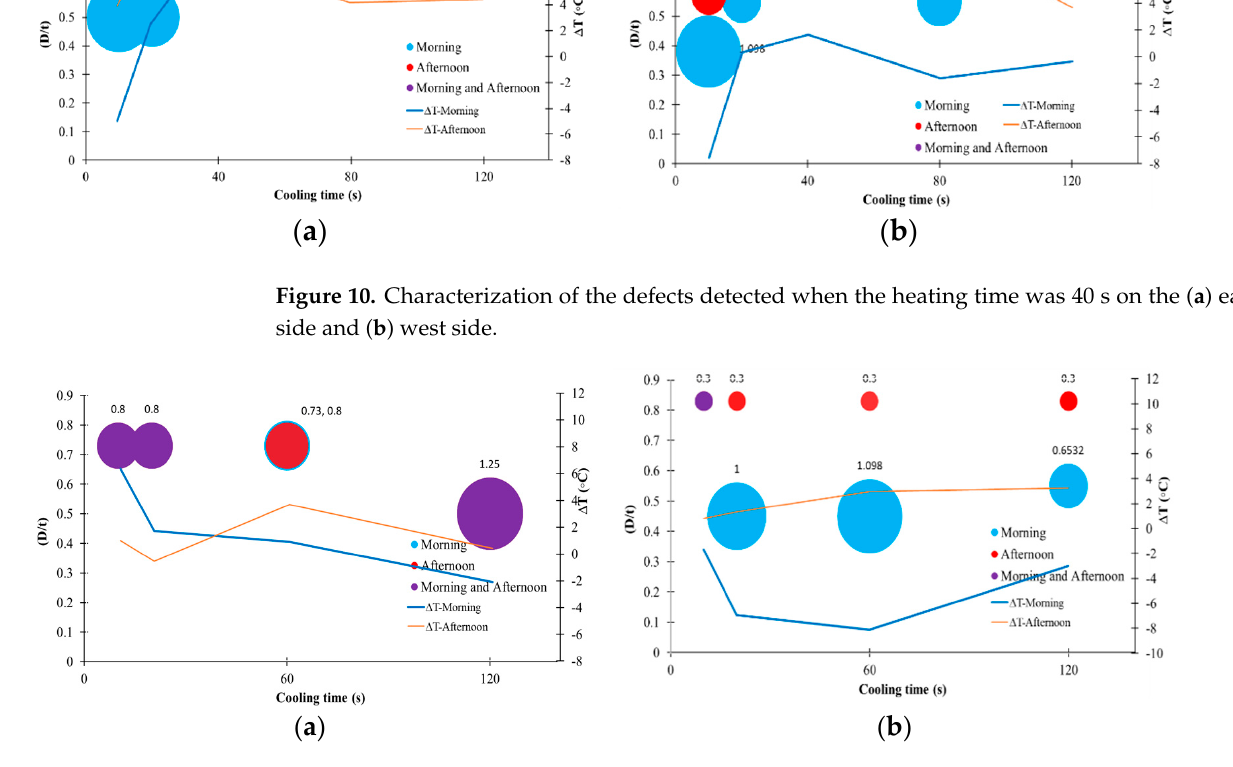
Figure 11. Characterization of the defects detected when the heating time was 60 s on the ( a ) east side and ( b ) west side.